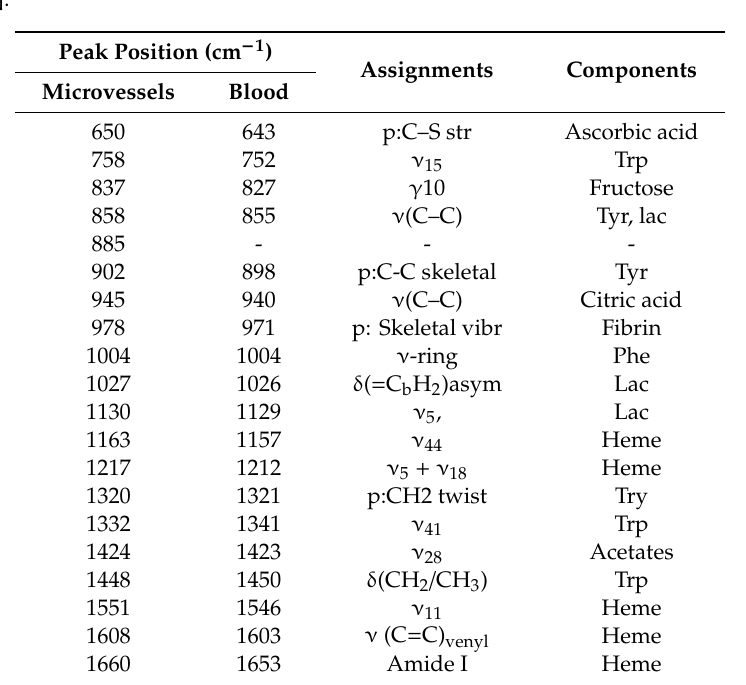
Figure 3. The typical Raman spectra of volunteers during the OGTT experiment. The different colors represent blood glucose levels at different times in one day. Table 1. Assignments of Raman peaks that are identified in the spectra of the microvessels and blood